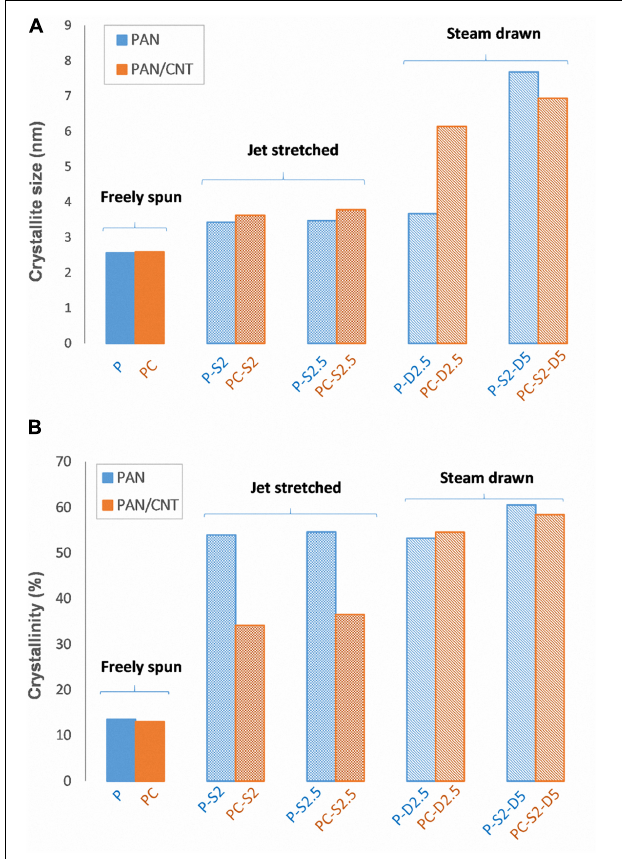
FIGURE 6 | Comparison of crystalline parameters of PAN/CNT and PAN fibers at different st retching conditions: (A) Crystallite size, (B) Crystallinity.